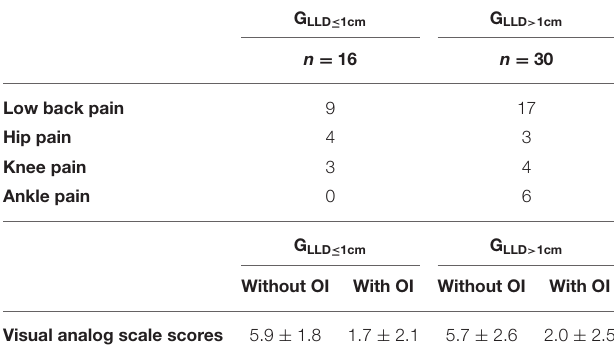
TABLE 5 | Localization of pain of the subjects included in each